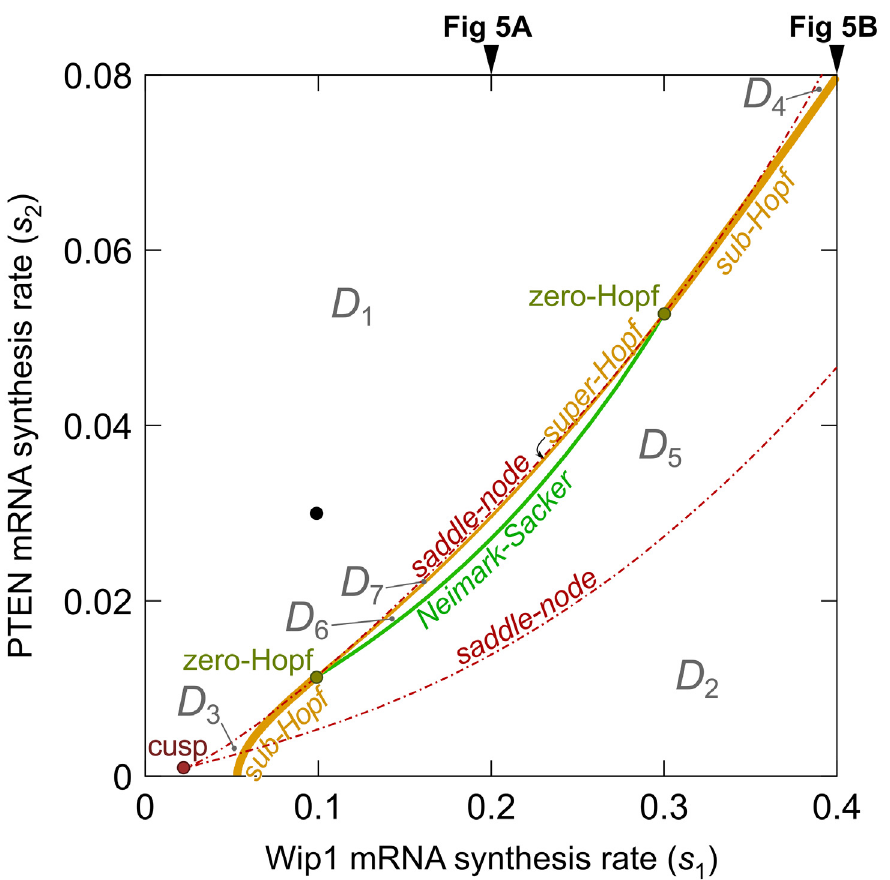
Fig 4. Two-dimensional bifurcation diagram showing various types of bifurcation lines and points in the (Wip1 synthesis rate, PTEN synthesis rate)-plane. The black dot indicates nominal values of parameters s 1 and s 2 . The bifurcation lines divide the parameter domain into seven subdomains D 1 , ... , D 7 . The recurrent solutions in each of these domains are given in main text. Bifurcation diagrams in Fig 5A and 5B show the recurrent solutions obtained for s 1 = 0.2 and s 1 = 0.4, as indicated by black arrows, and varied s 2 .